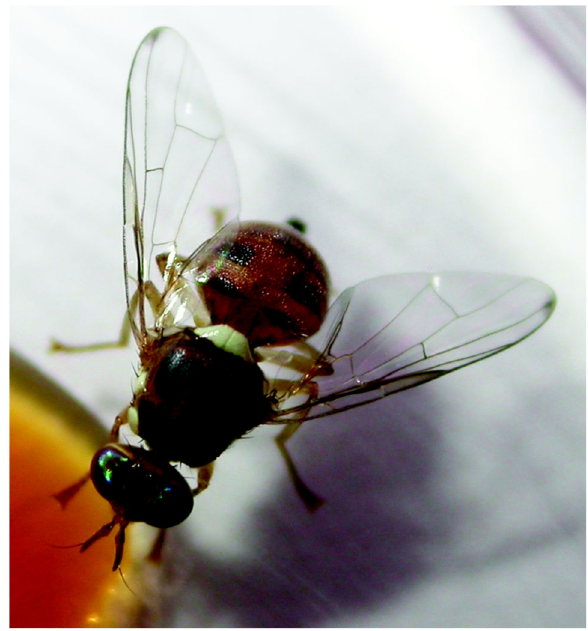
Figure 1. Female olive fly. doi: